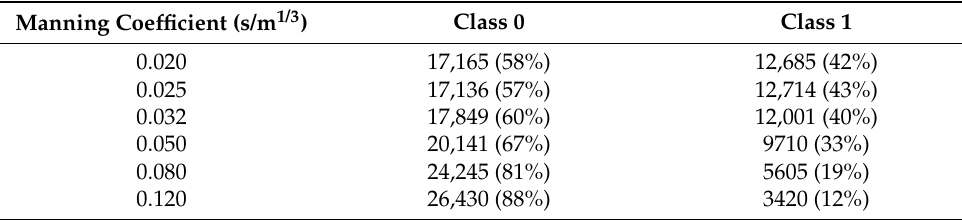
Table 2. Class distribution versus Manning coefficient for the training